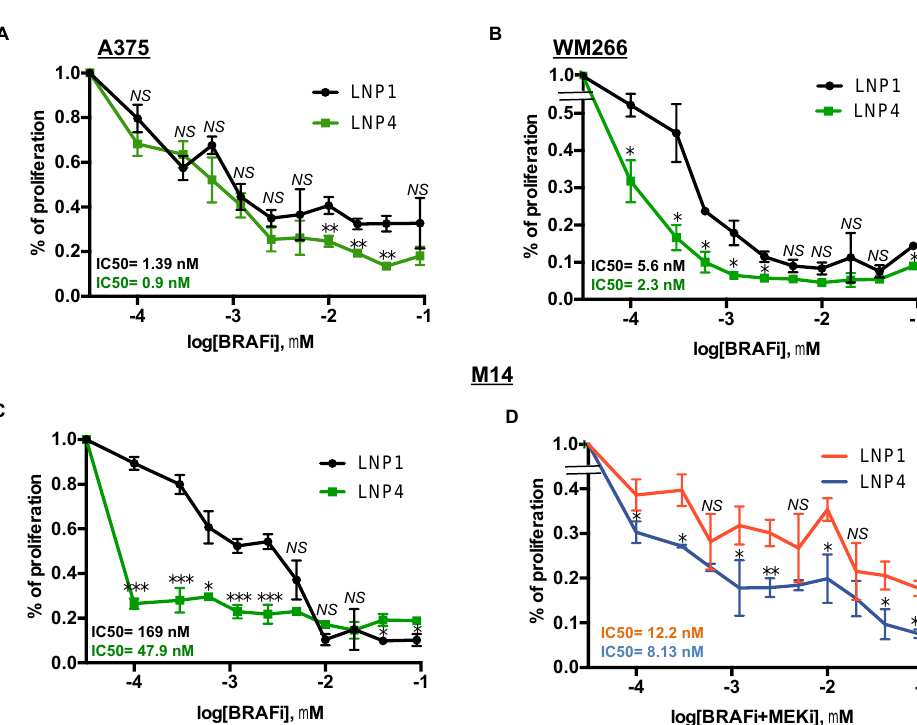
Figure 4. LNP4 potentiates MAPKi growth inhibitory e ff ects on human melanoma cells. A375 ( A ), WM266 ( B ) and M14 ( C ) cells were exposed to dabrafenib in the presence of LNP1 or LNP4 to measure cell viability through ATP reading. LNPs were used at fixed concentration of 30 µ g, whereas BRAFi starting from 3 µ M and then diluted 1:2 for ten times. ( D ) M14 cells were tested for the combination of dabrafenib + trametinib + LNPs. LNPs and BRAFi were used as described above, whereas MEKi starting from 1.5 µ M and then diluted 1:2 for ten